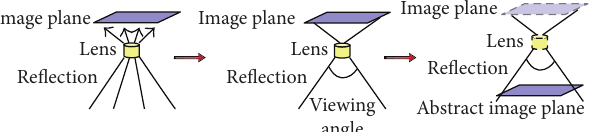
Figure 8: Abstraction of the model of the spectrometer.